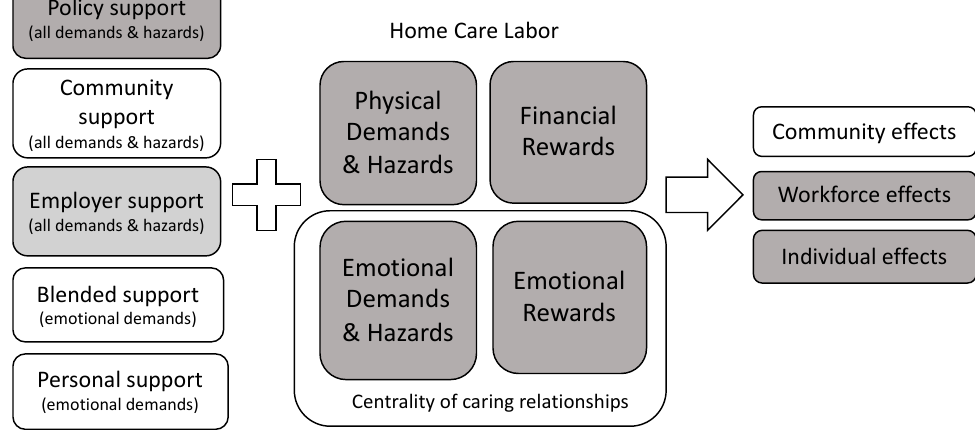
Figure 2. Types of support for carework labor experience and levels of effects. Note: Gray boxes are phenomena documented in the literature. White boxes are model elements that this study adds.